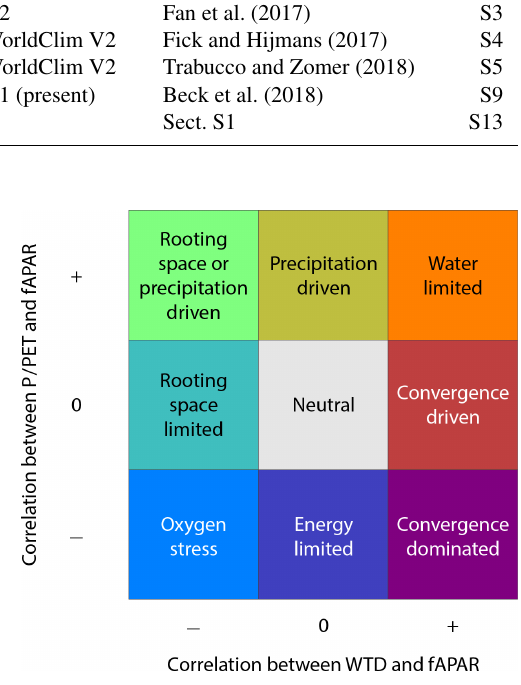
visually validated against several sample regions (Fig. S11 and